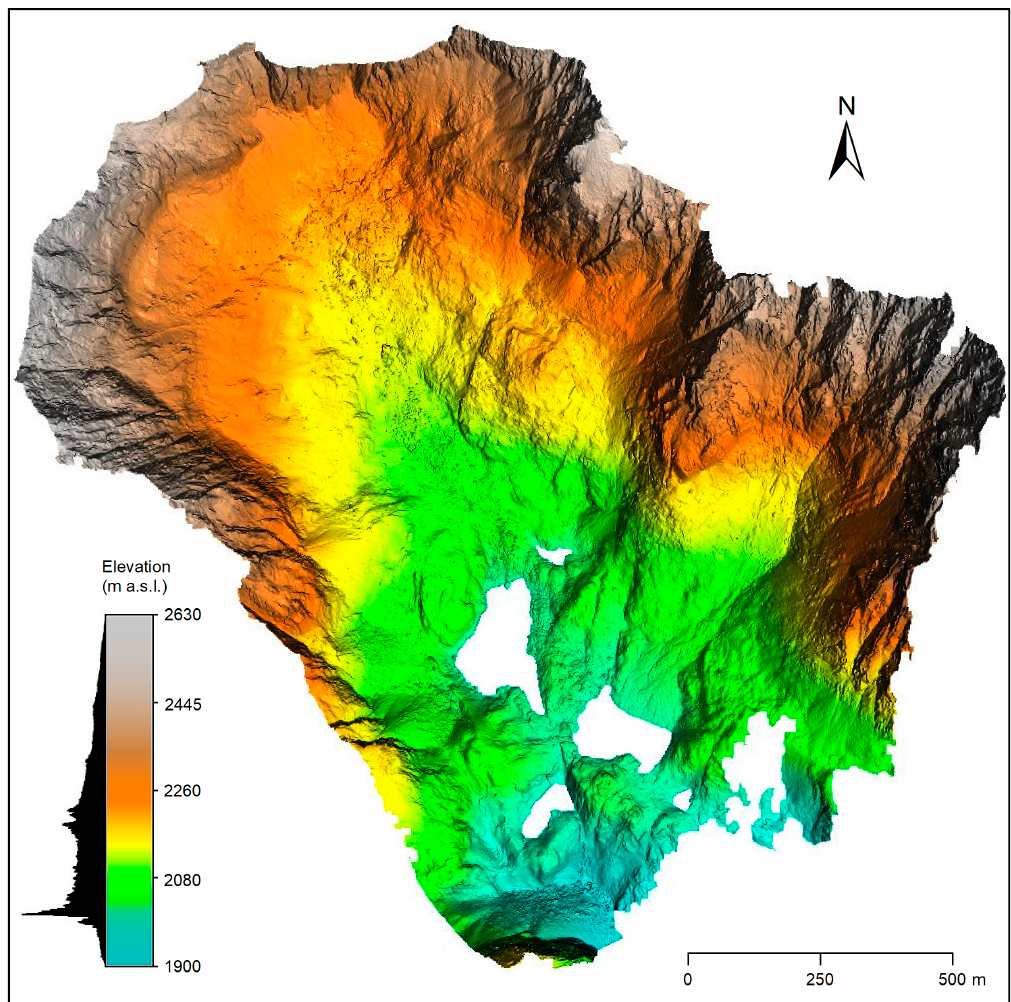
Figure 10. Digital elevation model derived from the combined TLS and UAV–SfM data with 0.5 m grid cell size.